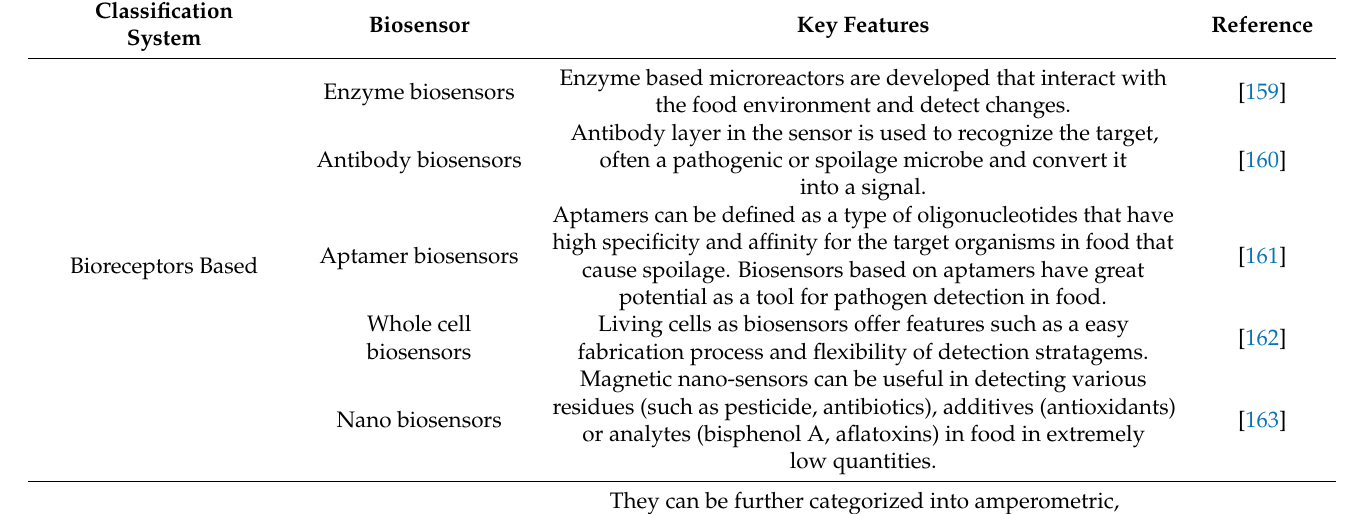
Table 3. Classification of various biosensors, along with their key